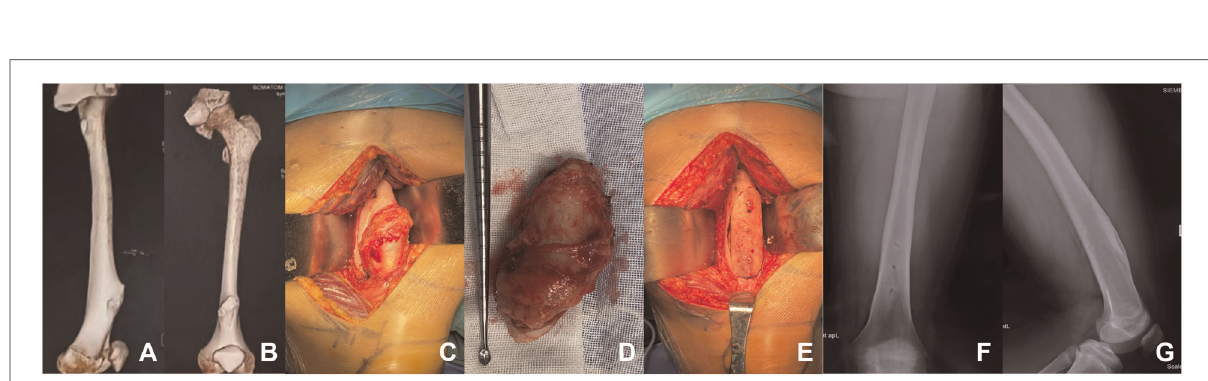
FIGURE 2 A patient with femoral osteochondroma. ( A,B ) The preoperative three-dimensional reconstruction of the patient showed a huge osteochondroma at the left femoral. ( C – E ) Osteochondroma resection was performed from the base of the tumor. The allograft was implanted in the bone cortical defect and fi xed with three absorbable screws. ( F,G ) One year after the operation, the radiographs of the left femur showed that the effect of bone graft fusion was